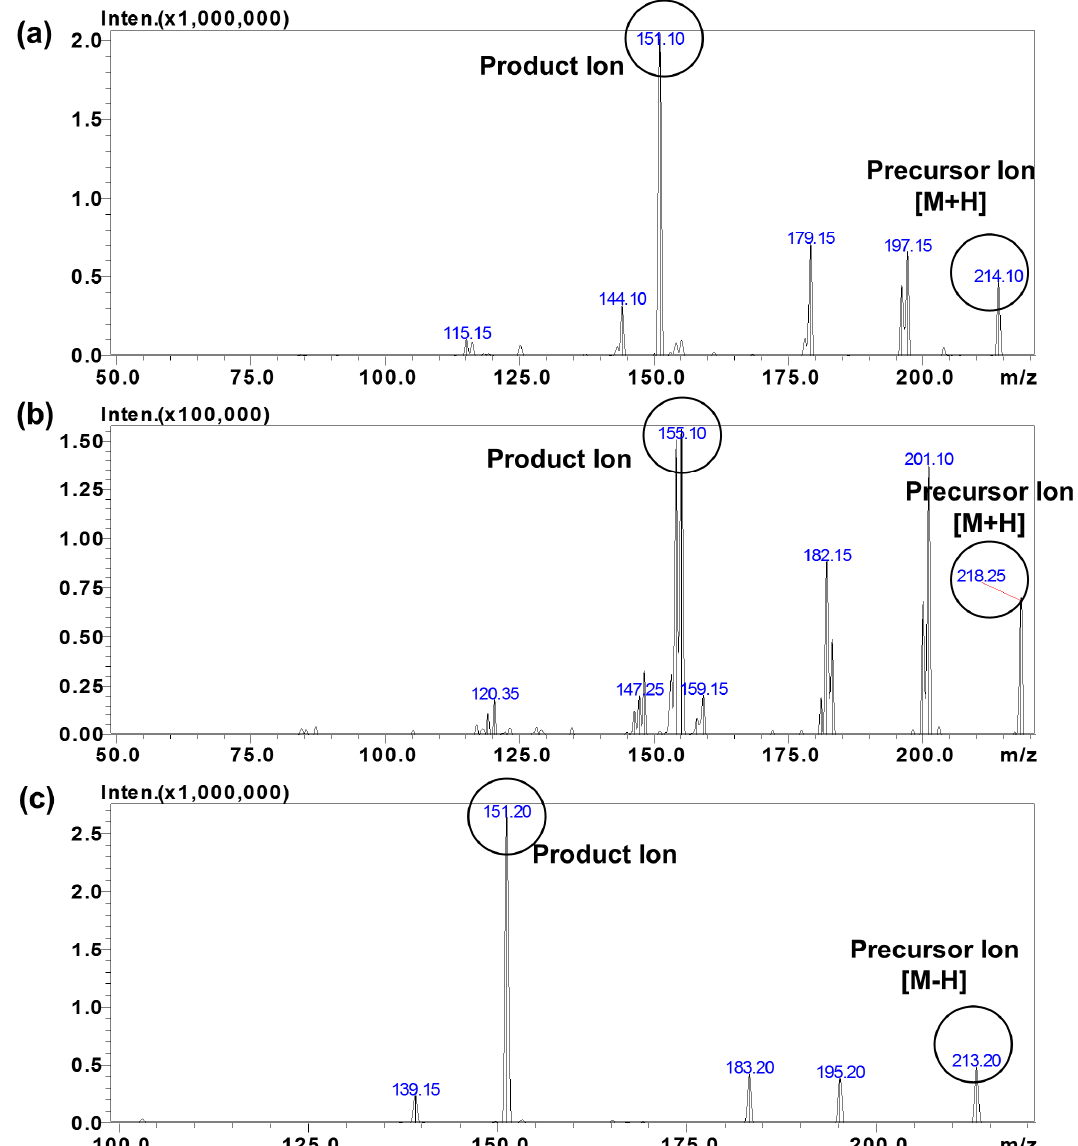
Figure 2. MS product ion spectra of ( a ) baclofen, ( b ) baclofen-d4, and ( c ) CHBA metabolite in +/– atmospheric pressure chemical ionization (APCI) mode.